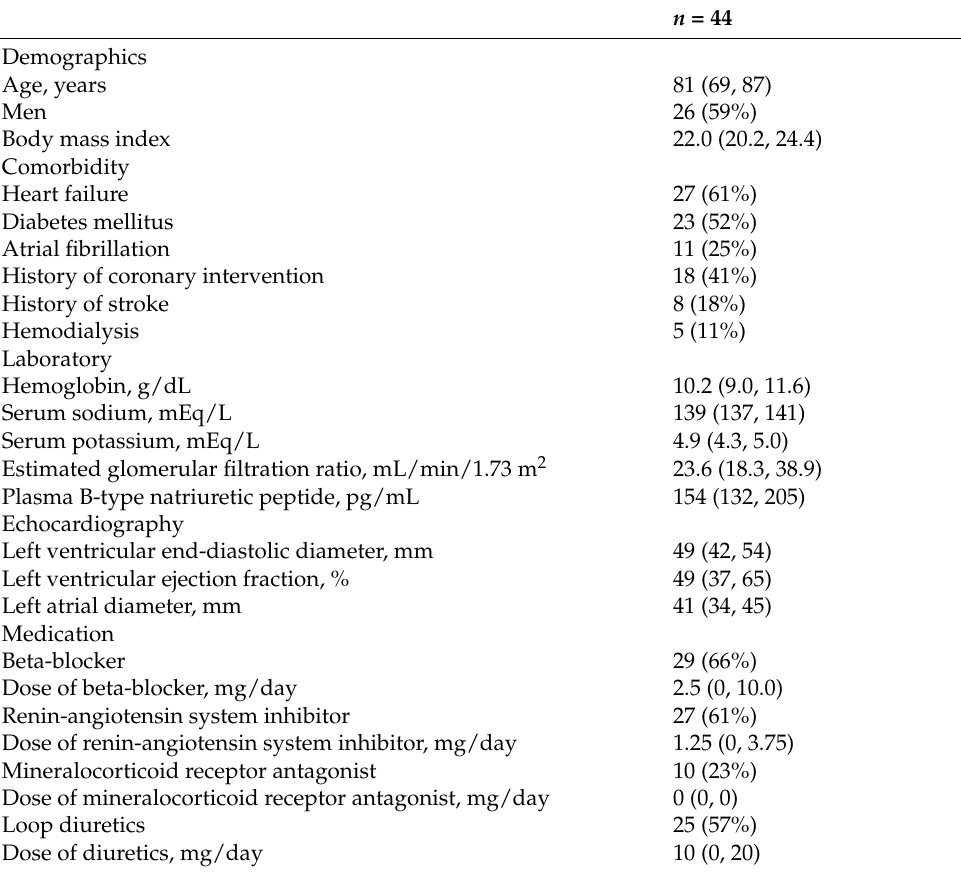
Table 1. Baseline characteristics at the time of SZC cessation.